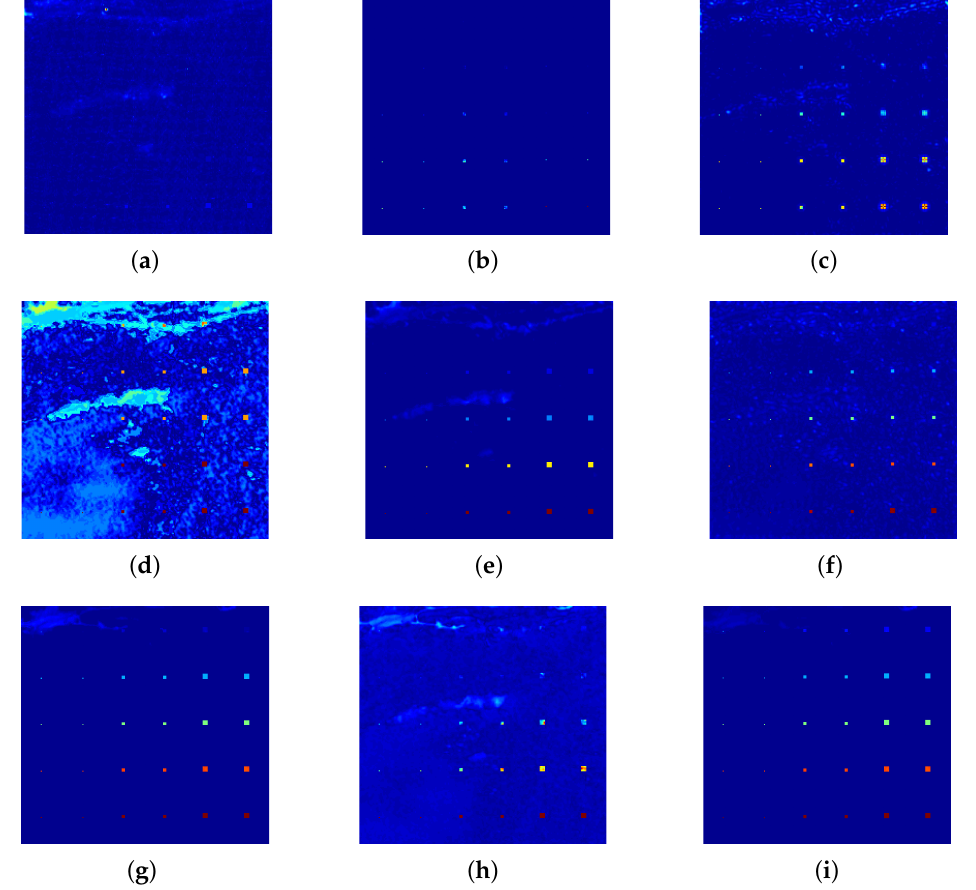
Figure 13. Color detection maps of all compared algorithms for the Synthetic dataset. ( a ) RX; ( b ) LRX; ( c ) KRX; ( d ) CKRX; ( e ) SSRX; ( f ) CRD; ( g ) LRaSMD; ( h ) LRASR; ( i )